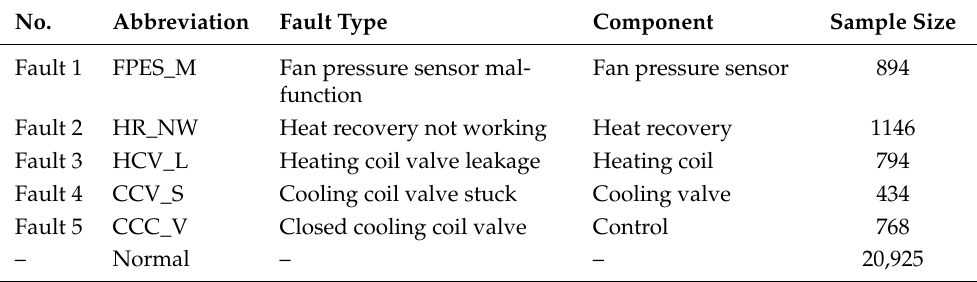
Table 3. List of AHU faults used in the analysis.